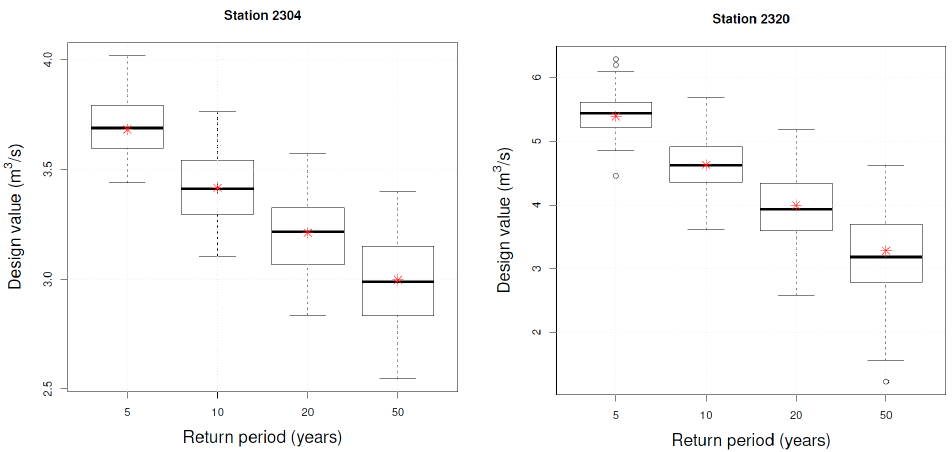
Figure 8. Upper Çoruh basin. Estimates of the univariate low-flow design values (red asterisks) associated with different return periods. Additionally shown are Monte Carlo boxplots providing an estimate of the corresponding uncertainty—see text.